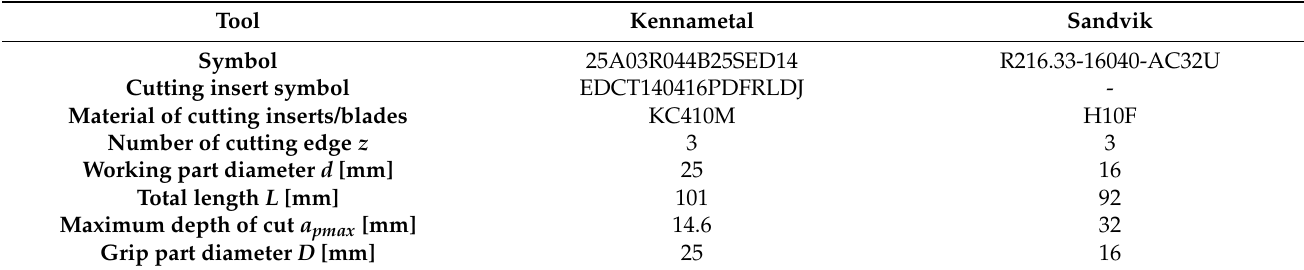
Table 3. Technical specifications of the tools used [51,52].